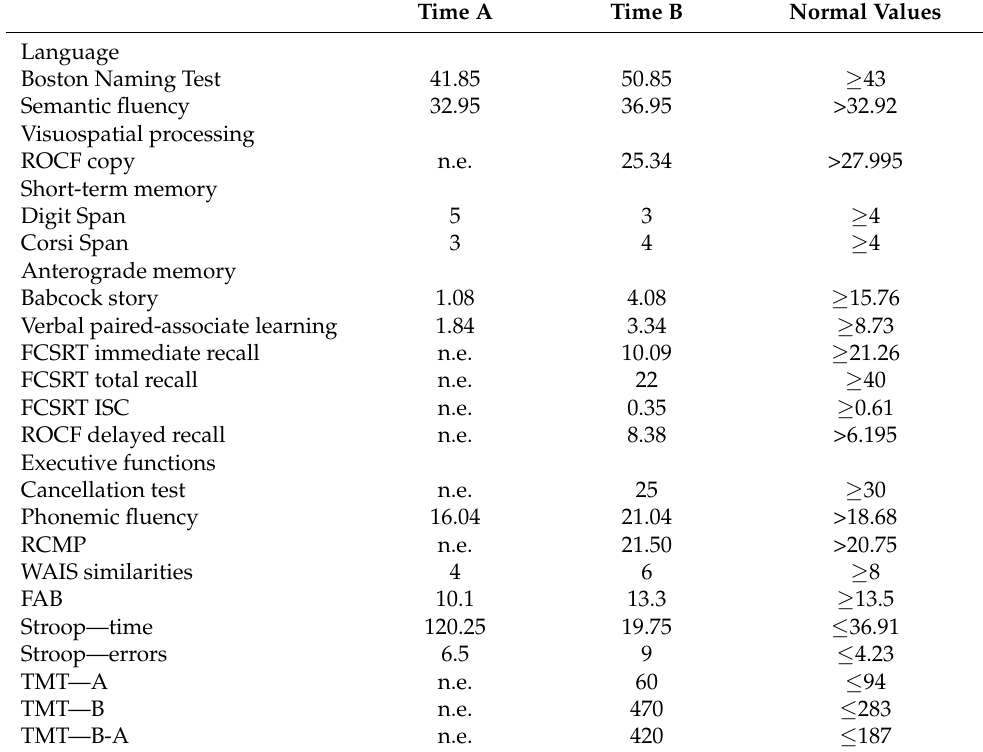
Table 1. Patient’s Neuropsychological Assessment.